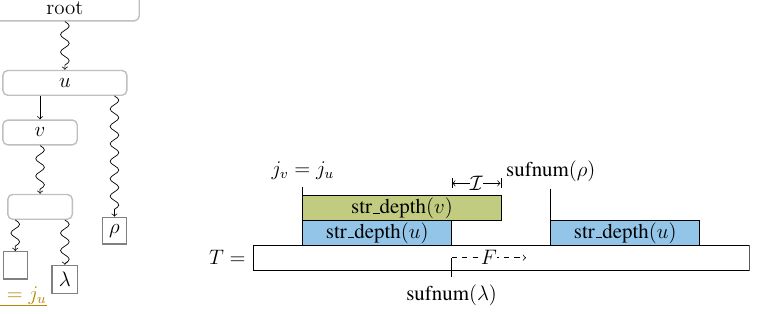
Figure 4. Special case of the setting considered in Figure 3 for factors of Types 2 and 3. Here, we assign u and v the same roles as in Figure 3, but we additionally assume that j v = j u and : = [ j u + str_depth ( u ) .. j u + str_depth ( v ) sufnum ( λ ) 1 ] . If sufnum ( λ ) = j u + str_depth ( u ) , as in the ∈ I − right figure, then the factor F of λ starting at sufnum ( λ ) is of Type 2, and the witness of F is u , although u is not the lowest ancestor of λ having λ and j u in its subtree. If sufnum ( λ ) j u + str_depth ( u ) , ∈ I \ { } then F is of Type 3 and the witness of F is v ; the witness of F is v even if λ and the leaf with suffix number j v are shared by a descendant of v as shown in the left